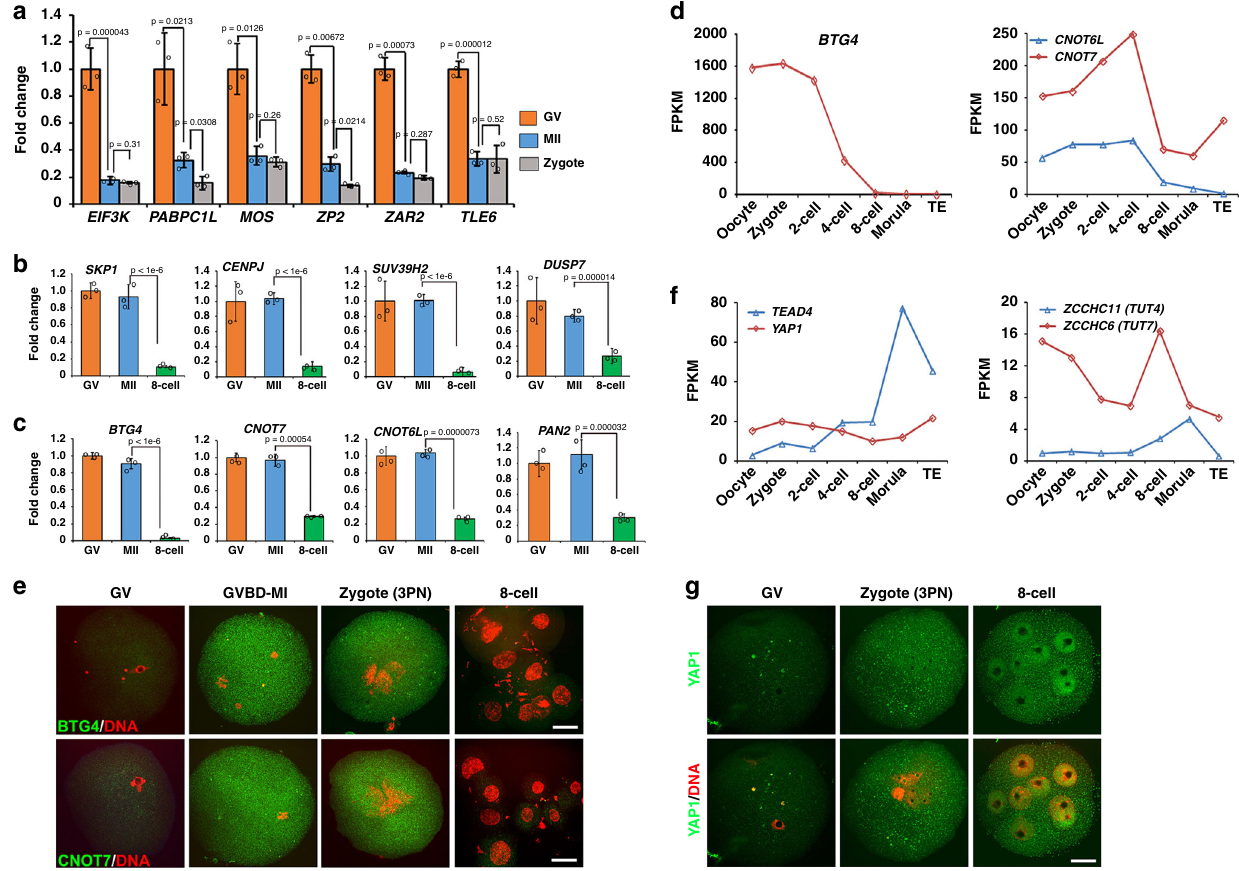
Fig. 3 mRNA dynamics of indicated genes during MZT in human. a RT-qPCR results showing the mRNA levels of selected M-decay transcripts at the GV, MII, and zygote (3PN) stages. b and c RT-qPCR results showing the mRNA levels of selected Z-decay transcripts at the indicated stages. Data are presented as mean values ± SEM. P by a two-tailed Student ’ s t -test. n = 3 biological replicates. d and e The RNA-seq results showing the levels of transcripts encoding key factors of the M-decay d and Z-decay e pathways in human oocytes and early embryos. FPKM values were extracted from previously published data (GSE36552 28 ). f and g Immuno fl uorescence results showing the protein levels of BTG4, CNOT7, and YAP in human oocytes, zygotes containing three pronuclei (3PN), and 8-cell embryos. Scale bars = 40 µ m. Immunostaining of each antibody was independently repeated for three times with similar Fig. 1a). Oocytes that overexpress TUBB8 V255M failed to assemble